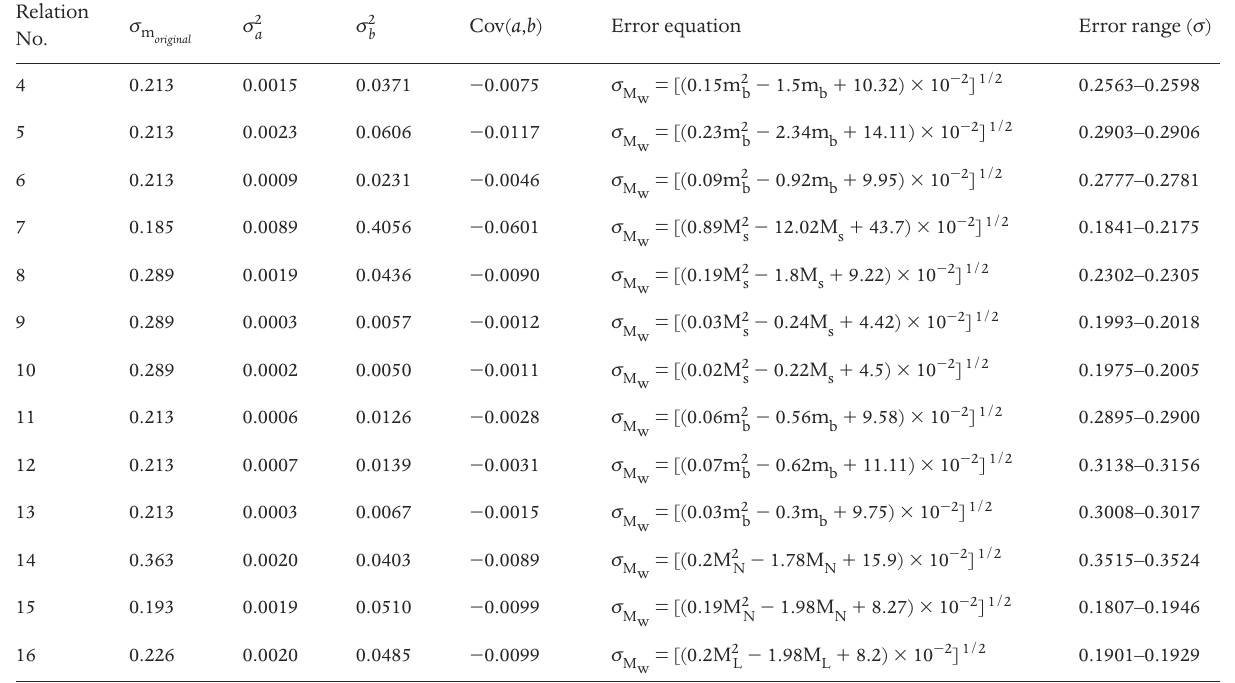
Table 7. Full error equations for the conversion relations of this study ( v ≈ 68% prediction